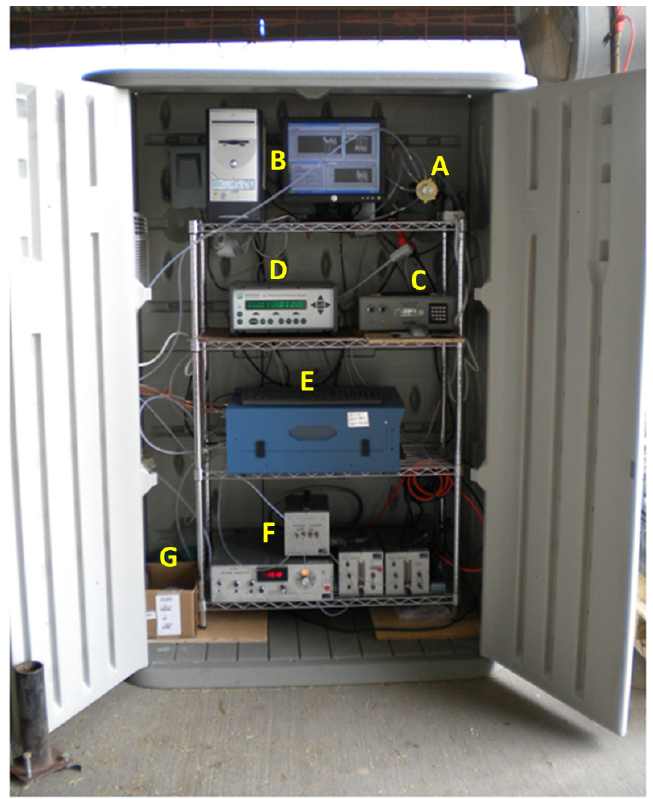
Figure 5. The instrumentation cabinet open while cattle were in both of the hoods. (A) is the rotary valve. (B) is the computer and monitor displaying the real-time data output of gas concentrations, RH/temp, and air flow rate. (C) is the carbon dioxide analyzer. (D) is the photoacoustic field gas monitor (INNOVA 1412). (E) is the direct methane/non-methane hydrocarbon analyzer (TEI-55C). (F) is the oxygen analyzer (sensor, readout/control unit, and 2 flow controllers (with pump, needle valve, and flow meter)). (G) is the sampling